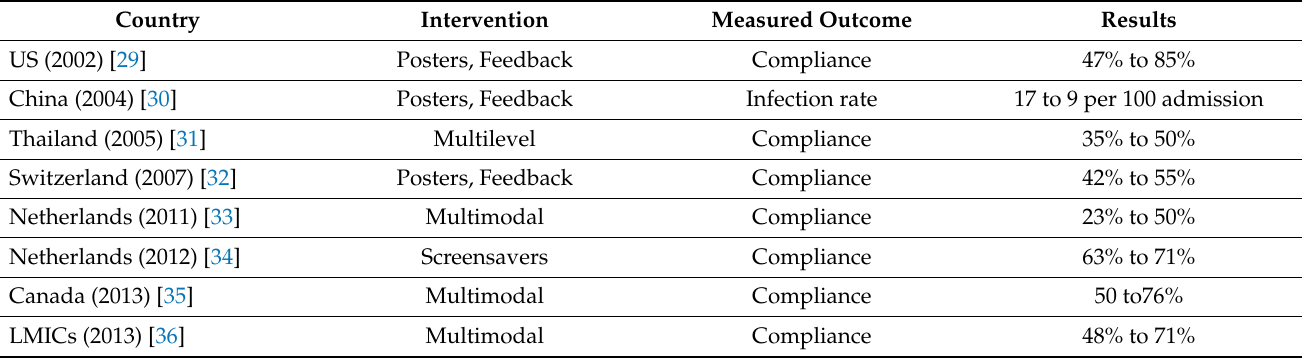
Table 3. Summary of Articles Studied to Increase Hand Hygiene Either Directly by Measuring Compliance or Indirectly by Measuring the Rates of Communicable Nosocomial